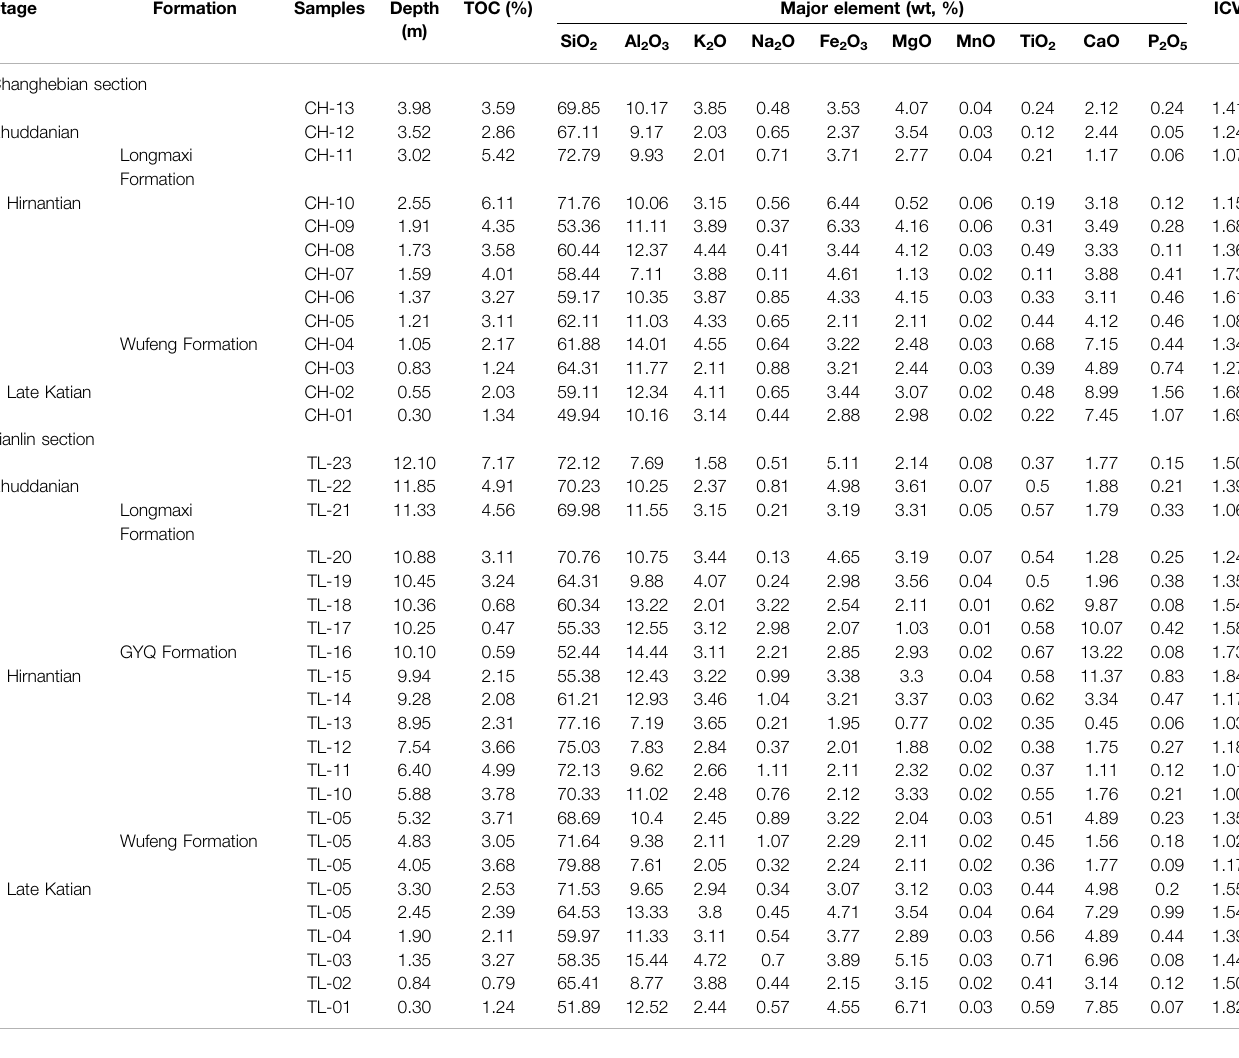
TABLE 1 | Results of the TOC and major elements in the Changhebian and Tianlin sections. Stage